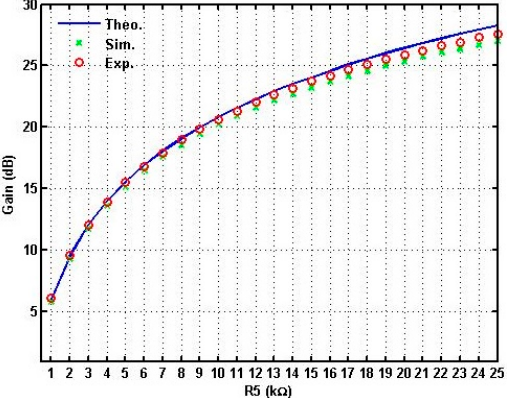
NBPF voltage gains at a voltage output of V BP5 .